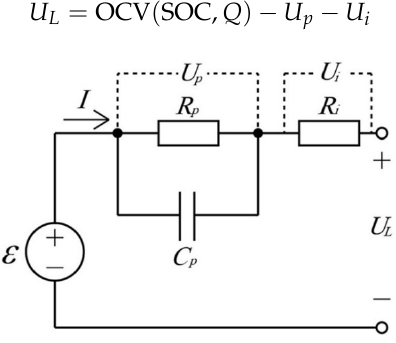
Figure 1. Equivalent circuit model (ECM) of a battery.